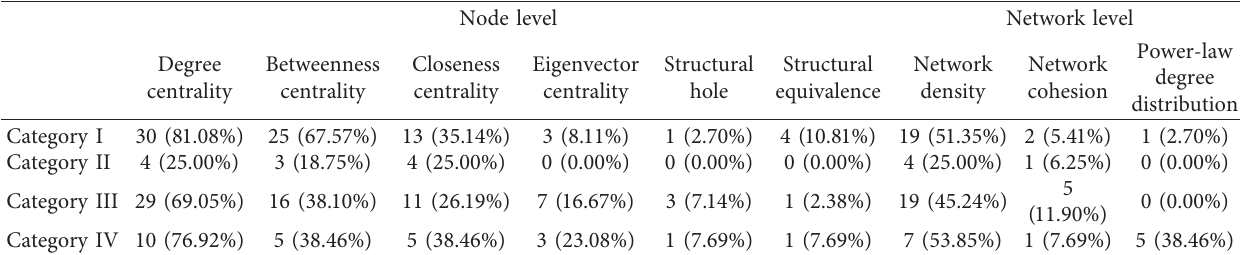
Table 8: Distribution of publications by SNA constructs and categories of network analysis.